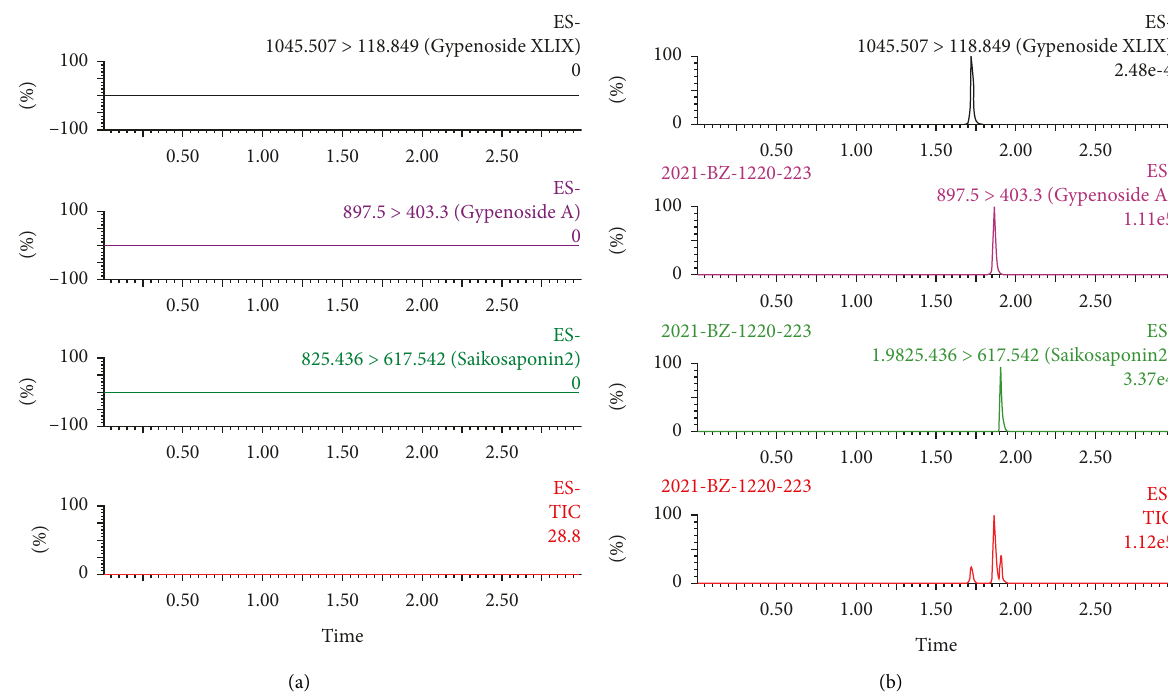
Figure 3: UPLC-MS/MS chromatograms of gypenoside A, gypenoside XLIX, and the internal standard in rat plasma (a) and blank rat plasma spiked with gypenoside A, gypenoside XLIX, and internal standard